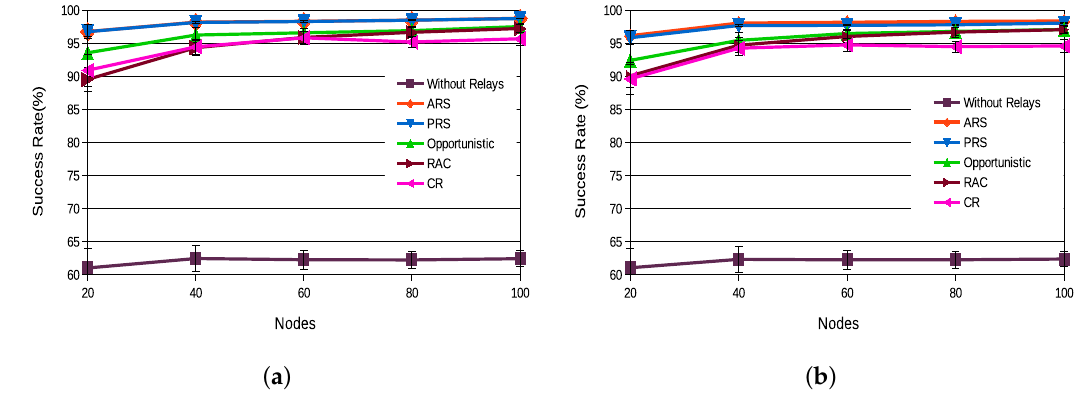
Figure 10. Success Rate—static topology ( a ) vs. dynamic topology ( b